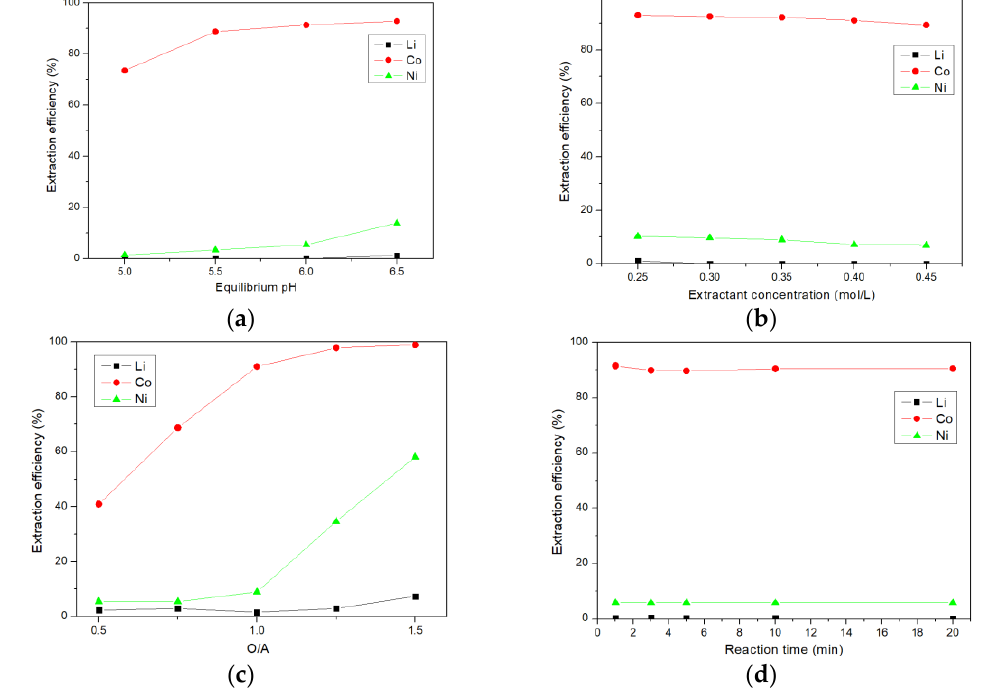
Figure 4. Effects of ( a ) pH ([Cyanex272] = 0.4 M, O/A = 1, t = 15 min), ( b ) extractant concentration (pH=6.0, O/A = 1, t = 15 min), ( c ) oil–water ratio (pH = 6.0, [Cyanex272] = 0.4 M, t = 15 min), and ( d ) reaction time on cobalt extraction (pH = 6.0, [Cyanex272] = 0.4 M, O/A = 1). Table 5. The relationship between the equilibrium pH and separation coefficient. Extractant Concentration